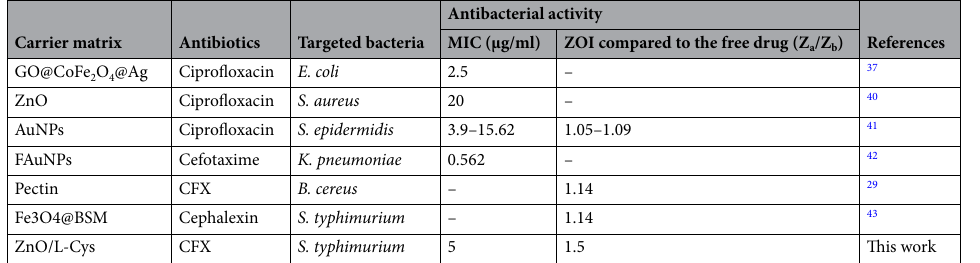
Table 3. Comparison of antibacterial activities of some Cephalosporin grouped antibiotic-loaded nanocarrier for different targeted bacteria as previously reported. Z a ZOI of nanocarrier conjugated antibiotics, Z b ZOI of the reference drug.